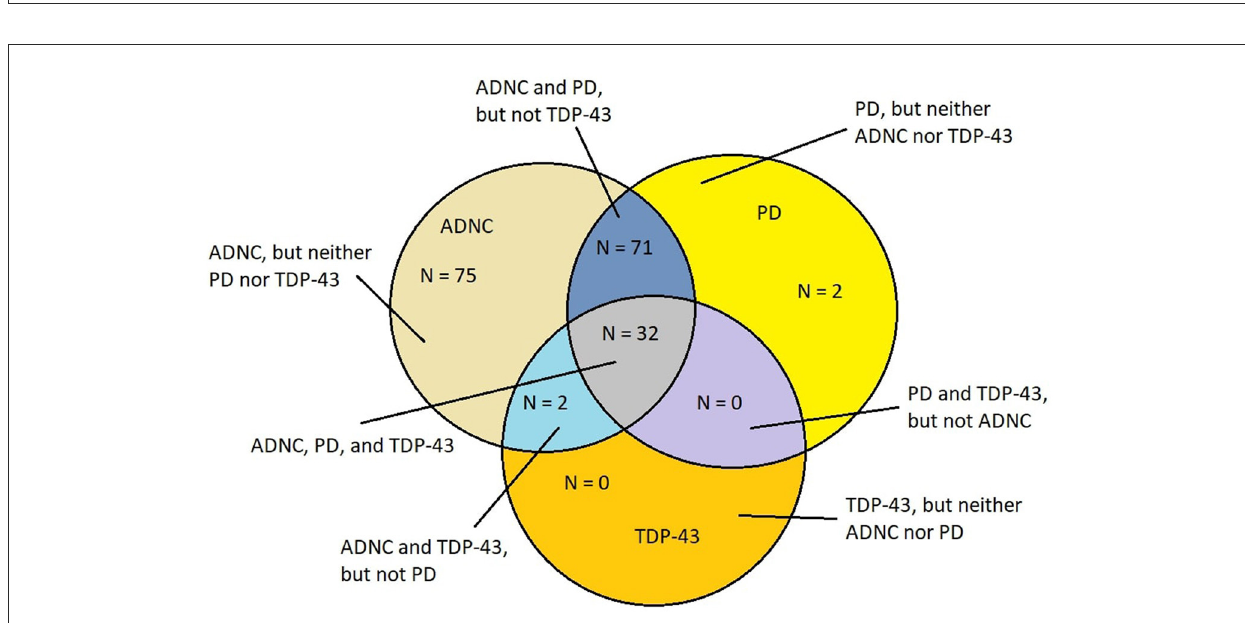
FIGURE4 Venn diagram showing the overlap of neurodegenerative fatal diseases in a cohort of 186 MMC residents with an average age of 27.3 ± 11.8 years (10). Alzheimer’s disease neuropathology changes (ADNC) (h-tau and A β ) were present in each case.